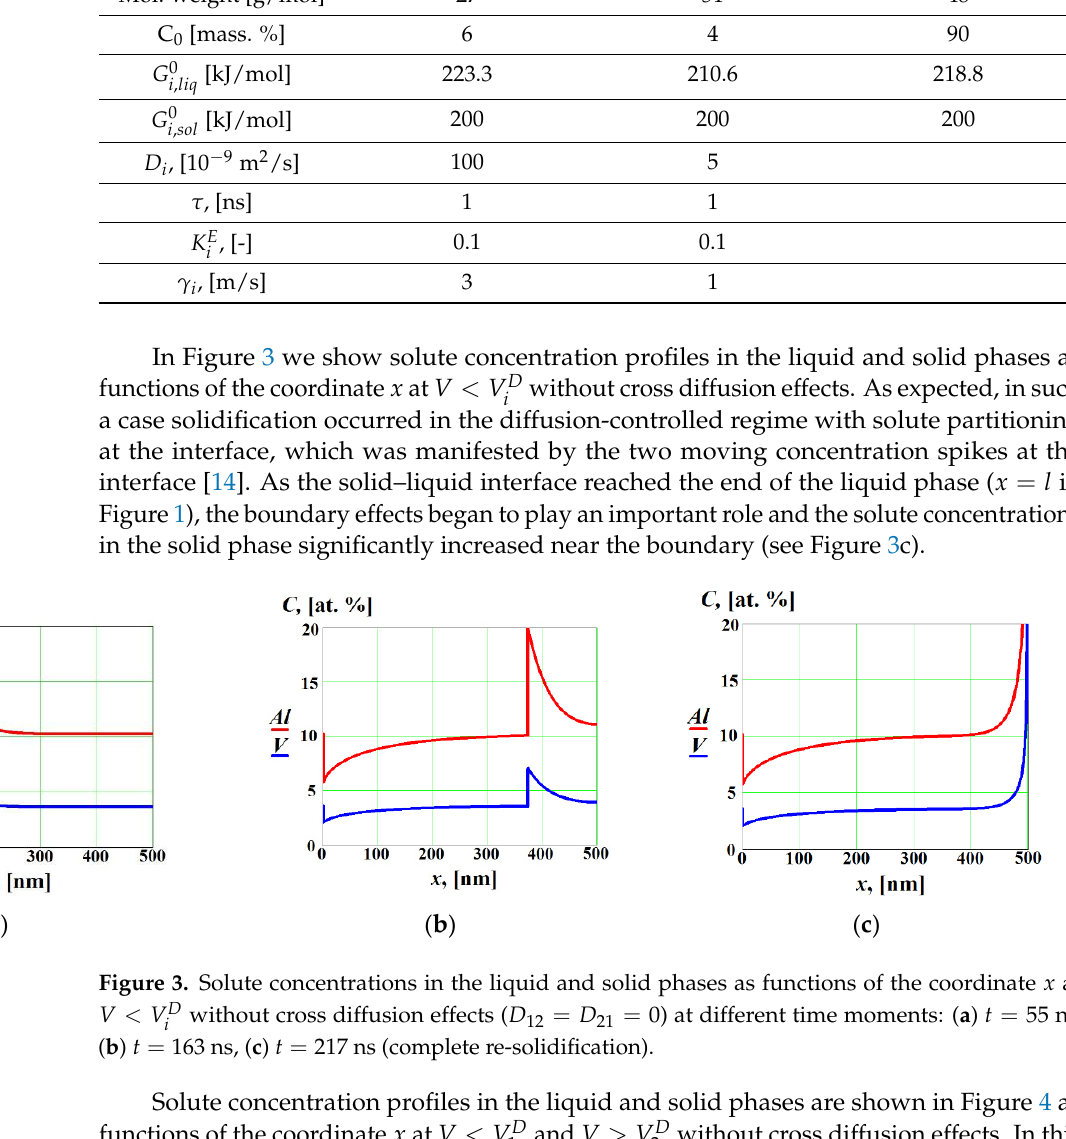
Figure 3. Solute concentrations in the liquid and solid phases as functions of the coordinate x at D V < V D without cross diffusion effects ( D 12 = D 21 = 0) at different time moments: ( a ) t = 55 ns, i ( b ) t = 163 ns, ( c ) t = 217 ns (complete